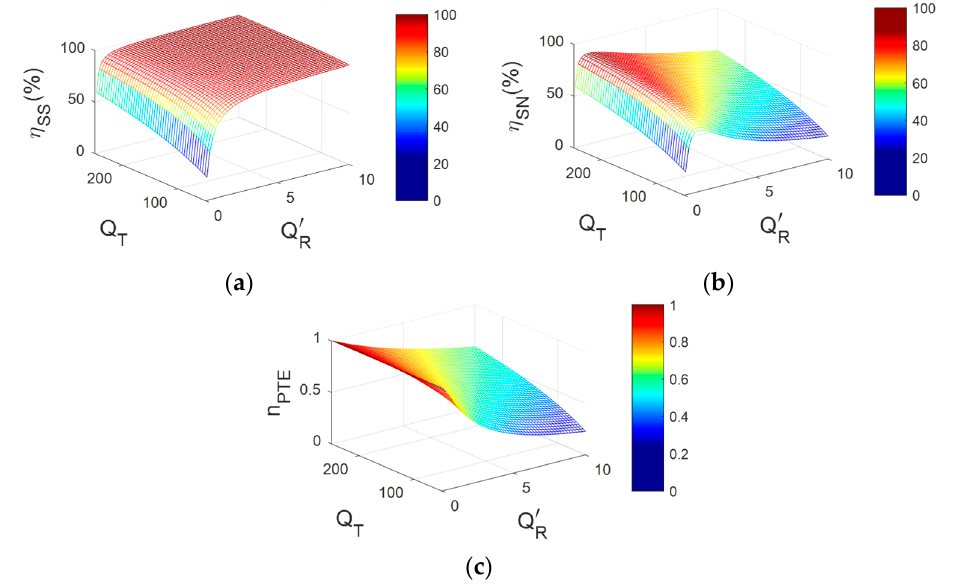
Figure 3. Calculated PTEs of ( a ) SS mode, η SS , ( b ) SN mode, η SN , and ( c ) PTE ratio of SS and SN modes, n PTE , as function of Q T and 𝑄 (cid:3019)(cid:4593) for k = 0.24 and R R = 0 Ω .